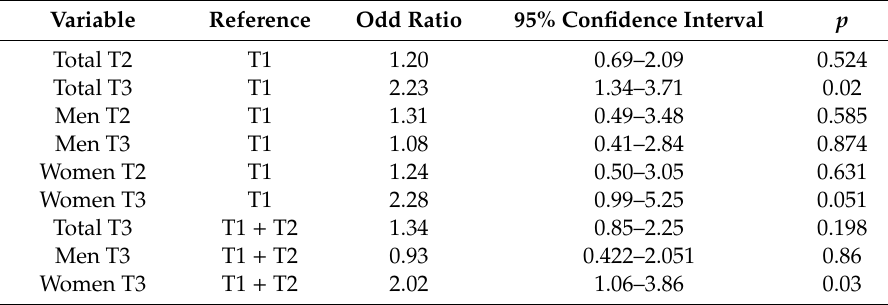
Table 3. Odds ratios of each tertile for SI / WMC on brain CT after adjusting for well-known risk factors for stroke such as age, hypertension, diabetes mellitus, dyslipidemia, and current smoking habits.